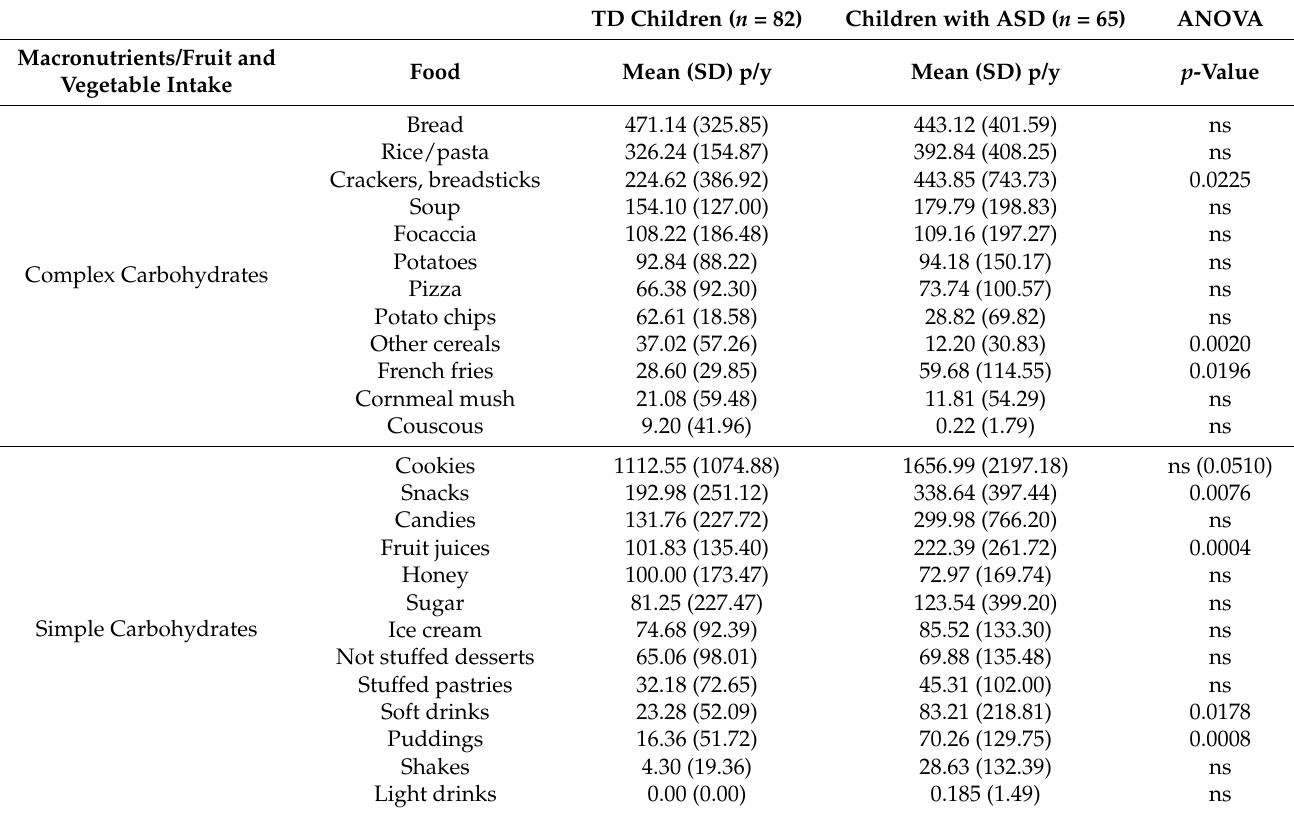
Table 3. The annual food consumption of typically developing children vs. peers with ASD. Mean values are expressed in portions/year, and foods are sorted by macronutrients/fruit, vegetable intake, and eaten